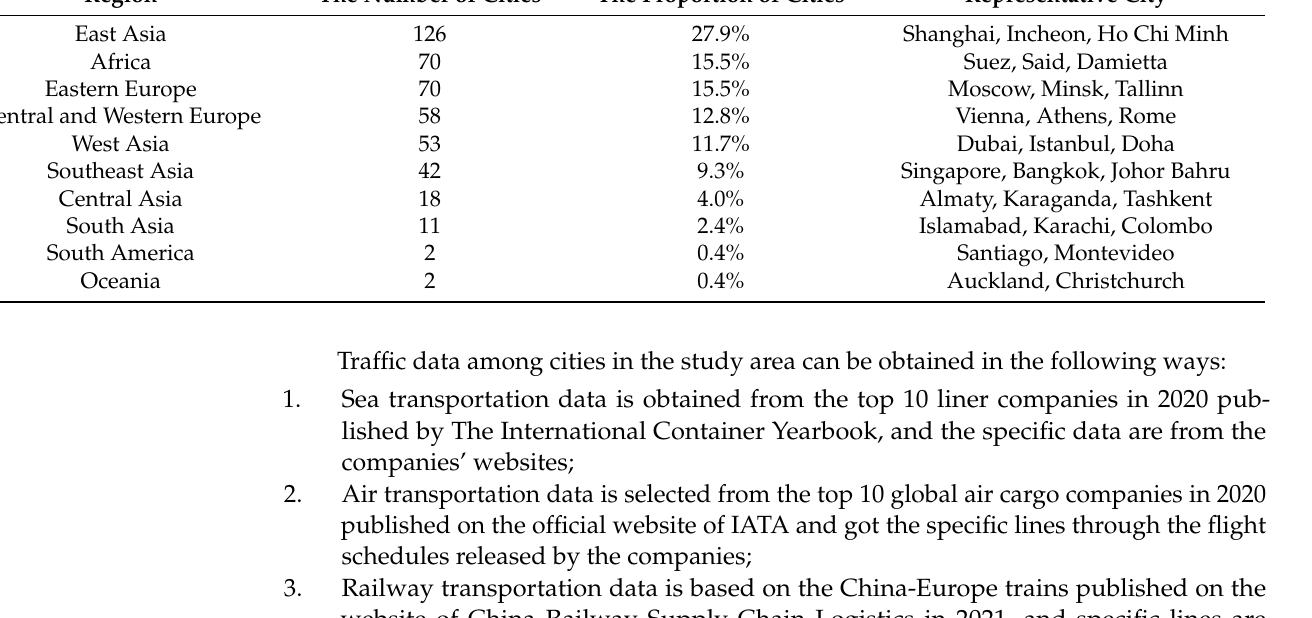
Figure 1. City distribution. Table 1. Distribution of cities within the study area. The number of cities The proportion of cities